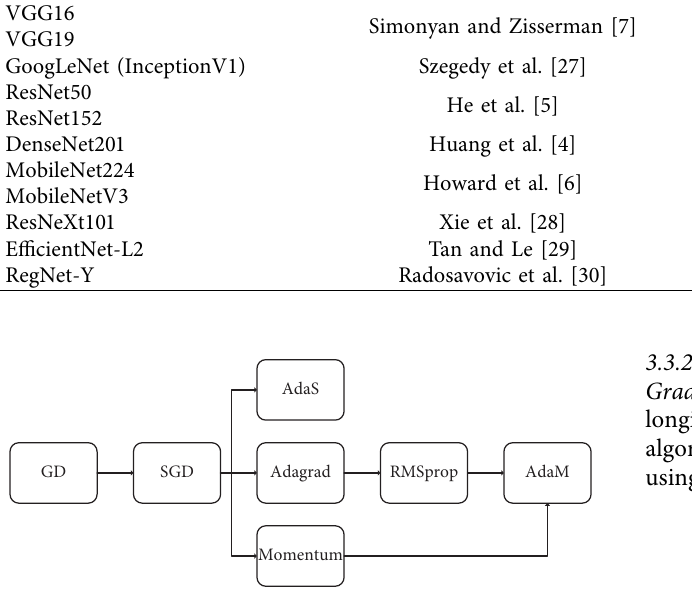
Figure 2: The development of optimization